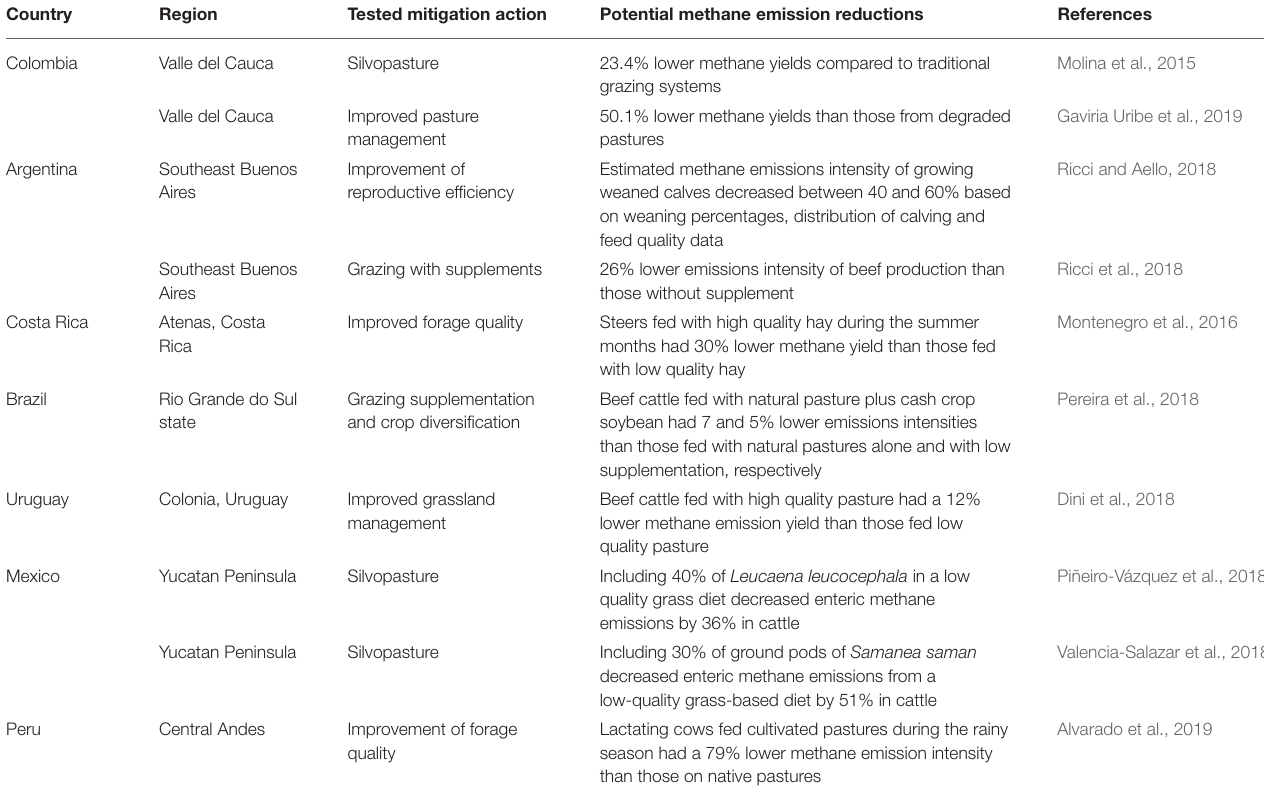
TABLE 2 | Methane mitigation options tested in seven countries of Latin America.